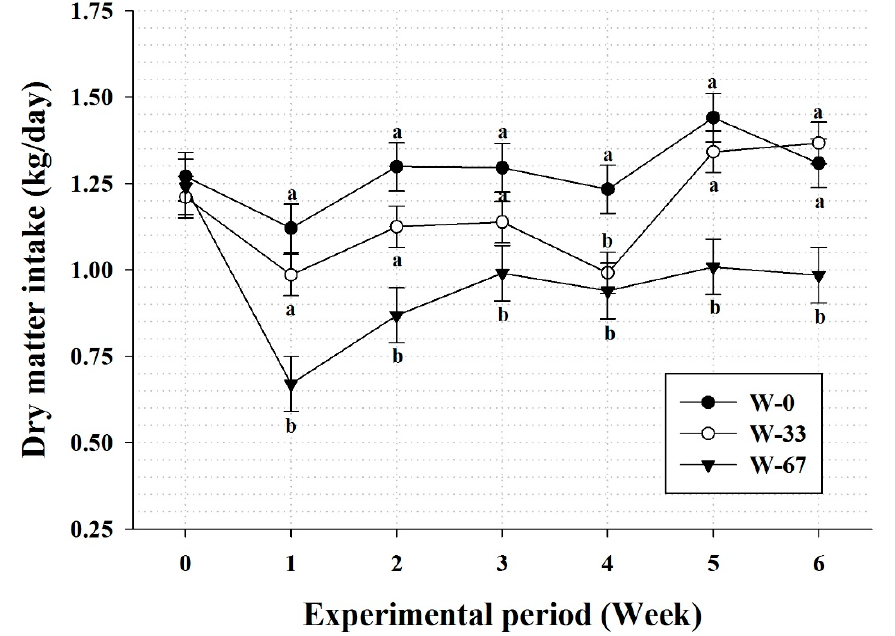
Figure 2. Dry-matter intake of water-restricted male Najdi lambs fed a pelleted diet throughout the experimental period. W-0: ad libitum water intake, W-33: 33% restriction of ad libitum water intake, and W-67: 67% restriction of ad libitum water intake. ab Measurements within the same week with di ff erent letters are significantly di ff erent at p <